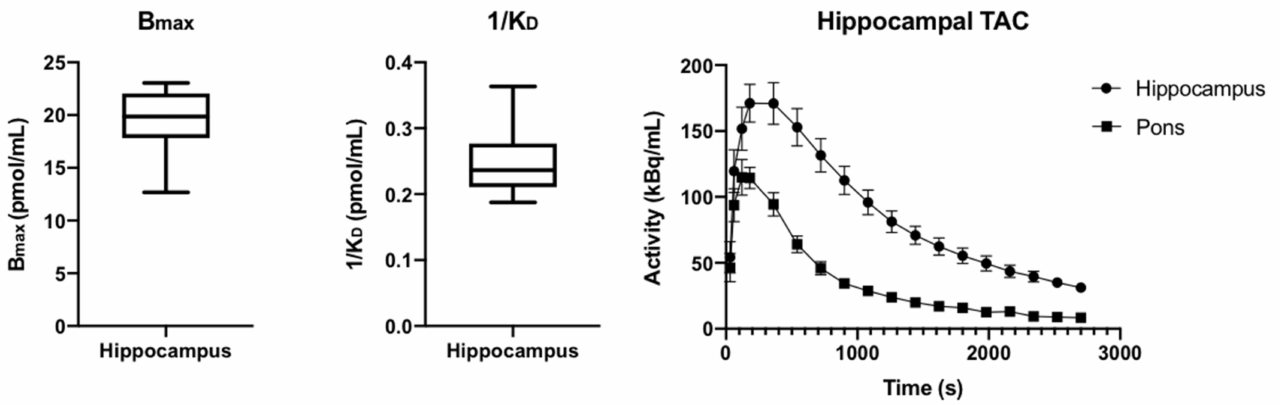
Figure 6. Box and whisker plots of hippocampal B max and 1/K D values and average time activity curves (TAC) from hippocampal and pons volumes of